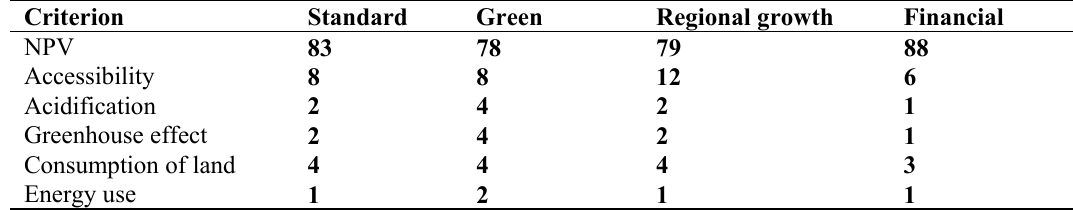
Table 4. Examples of sets of weights for MCA1.